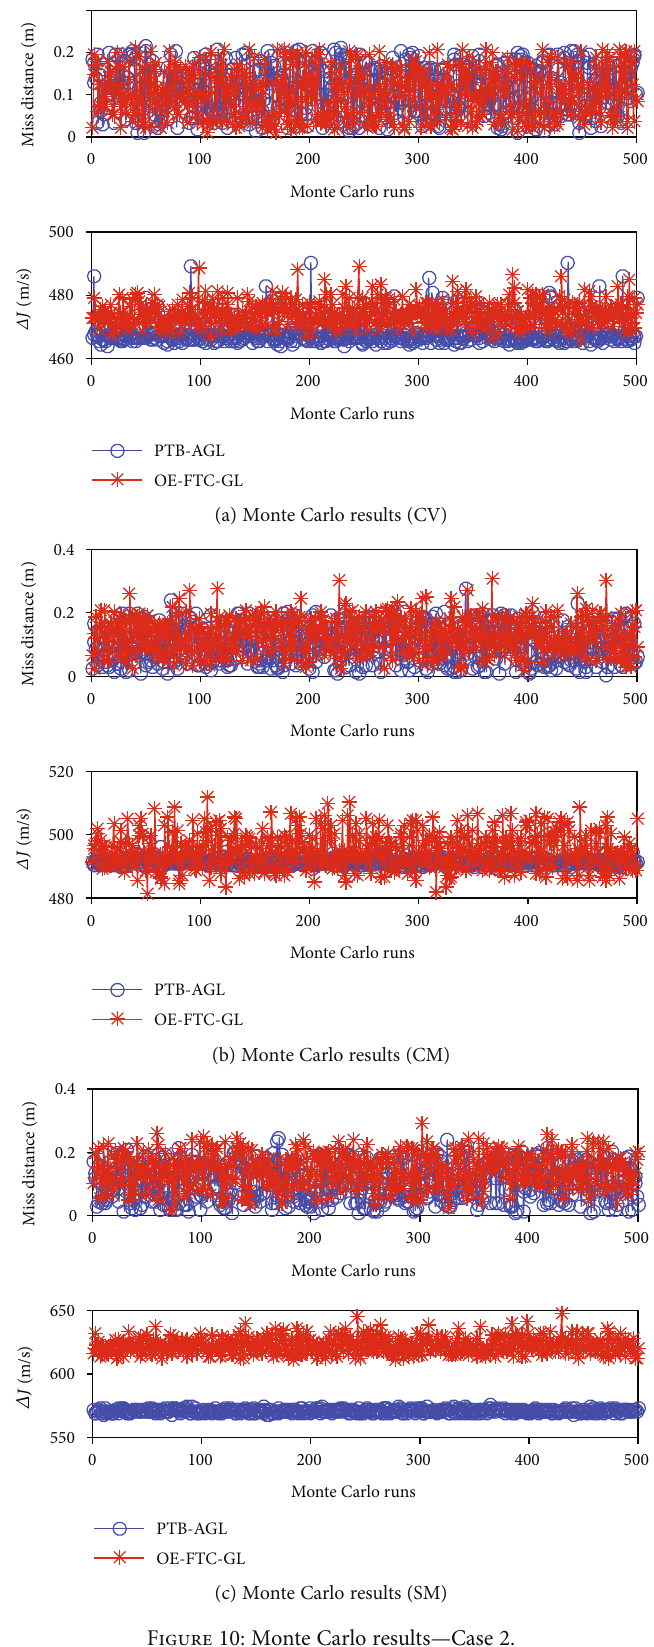
Figure 10: Monte Carlo results — Case